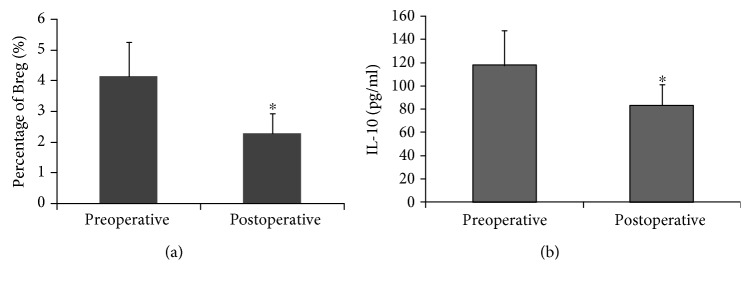
Preoperative and postoperative Breg and IL-10 in patients who underwent radical resection of cervical cancer. Among the 70 patients with cervical cancer, 57 patients underwent radical resection of cervical cancer and were followed up at 6 months after surgery. The preoperative and postoperative Breg percentages and IL-10 levels were analyzed in these patients. The number of Breg cells (a) and the level of IL-10 (b) before and after surgery were compared. ∗P < 0.05, compared with the preoperative group.